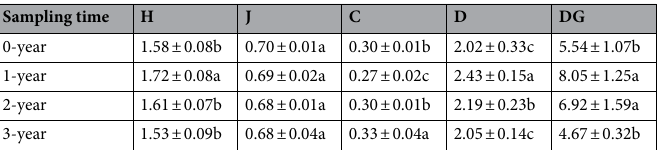
Table 2. Diversity characteristics of soil meso- and micro-fauna in different sampling times.